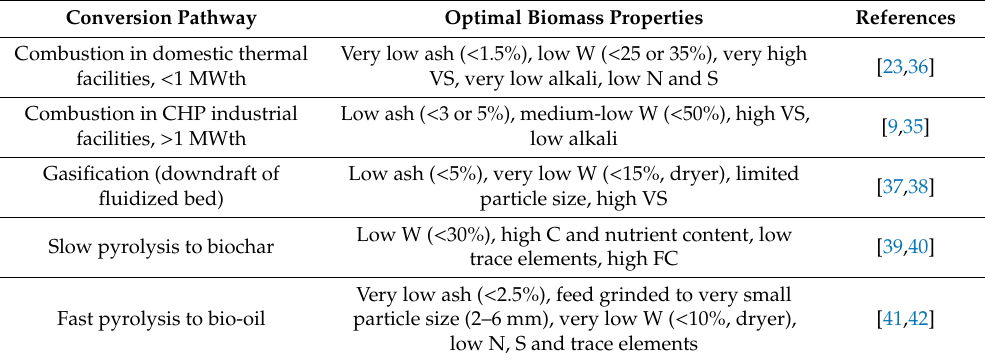
Table 4. Optimal biomass properties for thermochemical conversion pathways of biomass of relevance at present, as reported in previously published